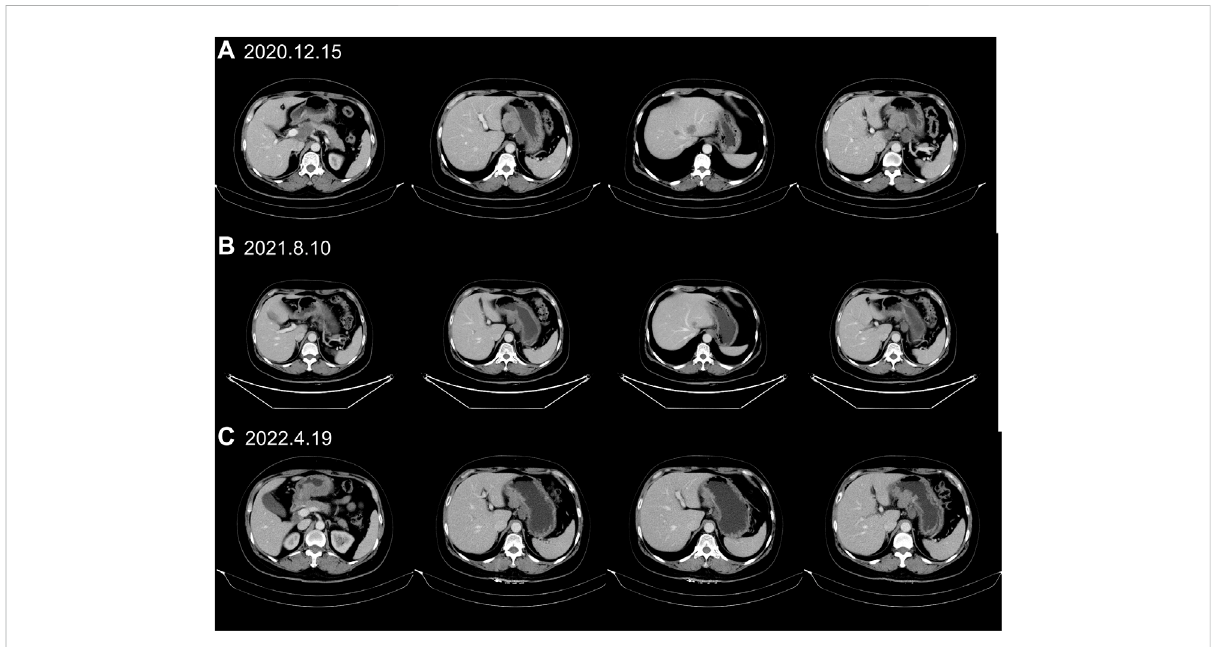
FIGURE 2 CT scans identi fi ed liver lesions during trastuzumab treatment. (A) CT scans (2020.12.15) demonstrated progressive disease (PD) in liver metastases after trastuzumab plus chemotherapy treatment. (B) CT (2021.8.10) showed that liver lesions had markedly shrunken 8 months after trastuzumab, apatinib and camrelizumab treatment. (C) The PR status (2022.4.19) continued with trastuzumab, apatinib and camrelizumab treatment until upper gastrointestinal bleeding happened.